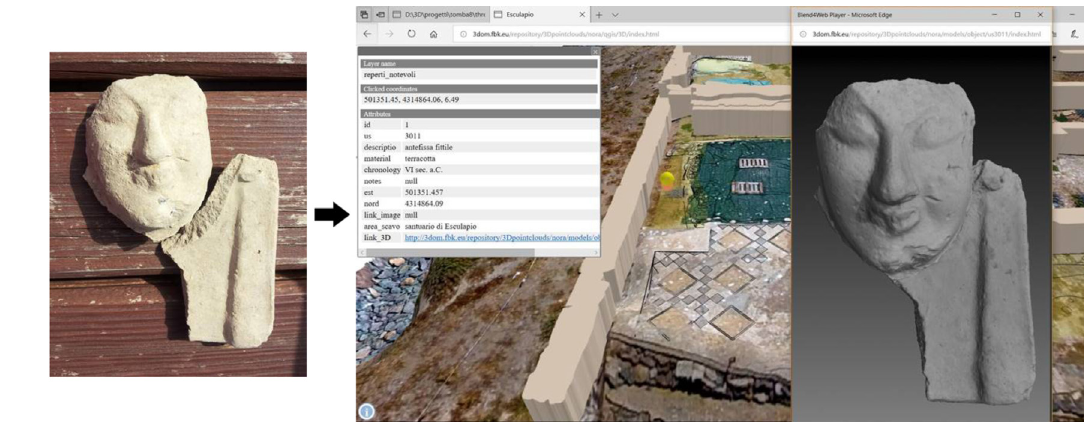
Figure 7. Re-contextualizing artifacts. Virtual restoration of the archaic protome, accessible by a Blender